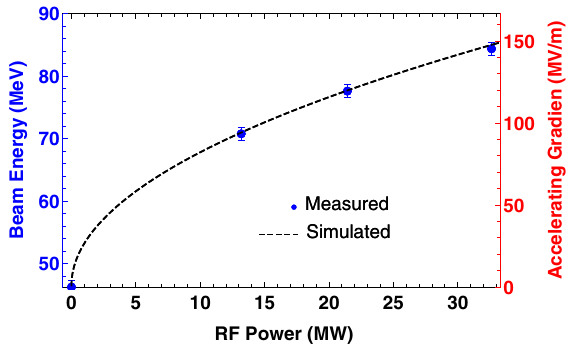
FIG. 6. The measured energy gain of an electron beam moving down the axis of the distributed-coupling linac for a compressed 200 ns square rf pulse with an input power of 13 – 33 MW, achieving an accelerating gradient of 100 – 150 MV = m and a peak surface electric field of 250 – 375 MV = m. Blue dots and the dashed line are measured and simulated values, respectively.